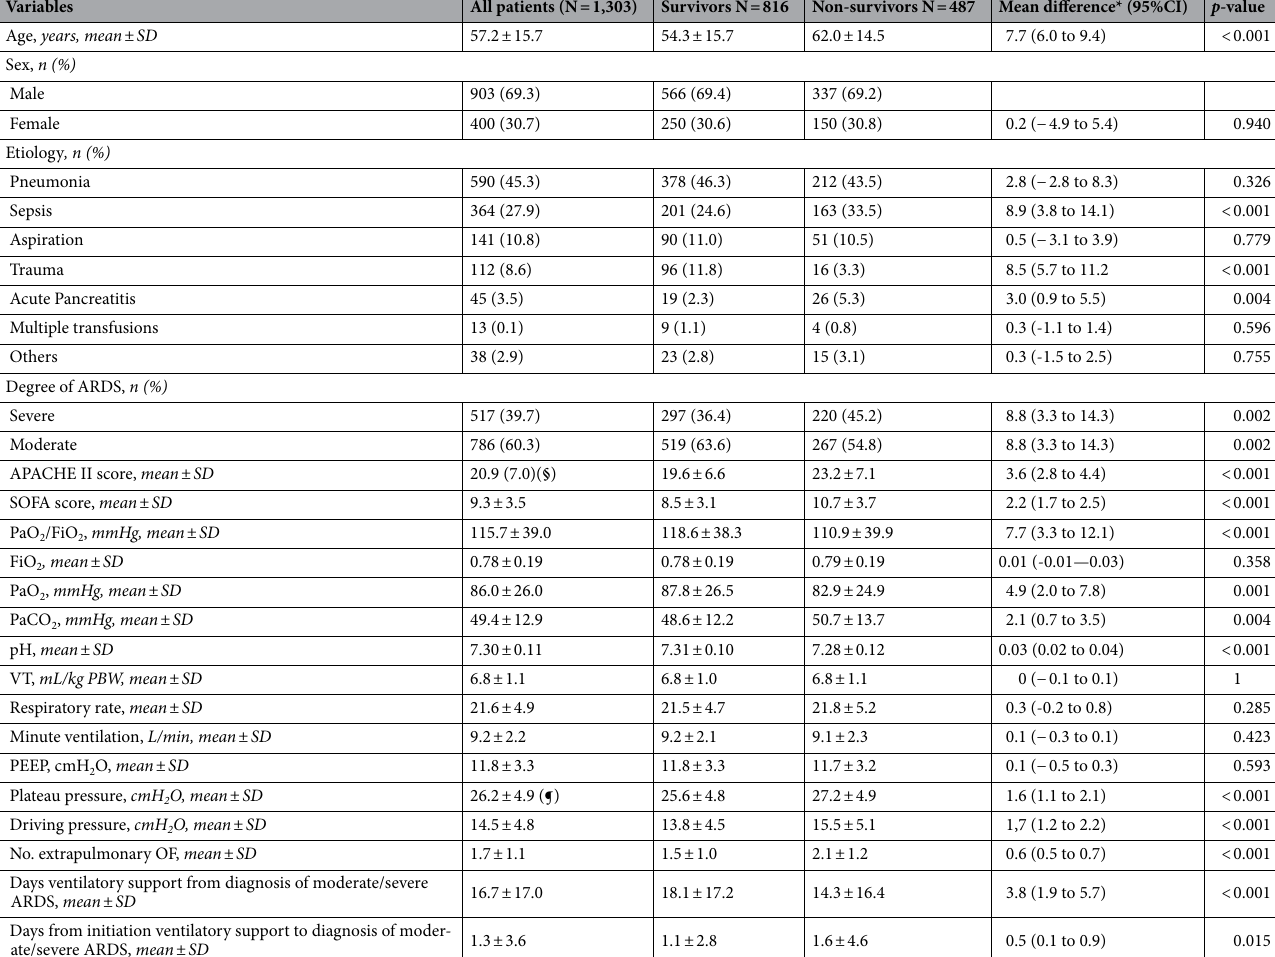
Table 1. Baseline characteristics and outcome data of an observational cohort of 1303 patients with moderate- to-severe acute respiratory distress syndrome (ARDS) at ICU discharge. (*) Mean difference represents the difference between values in survivors and non-survivors. APACHE, acute physiology and chronic health evaluation; ARDS, acute respiratory distress syndrome; CI, confidence interval; FiO 2 , fraction of inspired oxygen concentration; ICU, intensive care unit; OF, organ failure; PBW, predicted body weight; PEEP, positive end-expiratory pressure; SD, standard deviation; SOFA, sequential organ failure assessment scale; VT, tidal volume. (§) APACHE II was missing in 11 survivors and 8 non-survivors. (¶) Plateau pressure was missing in 6 survivors and 9 non-survivors.